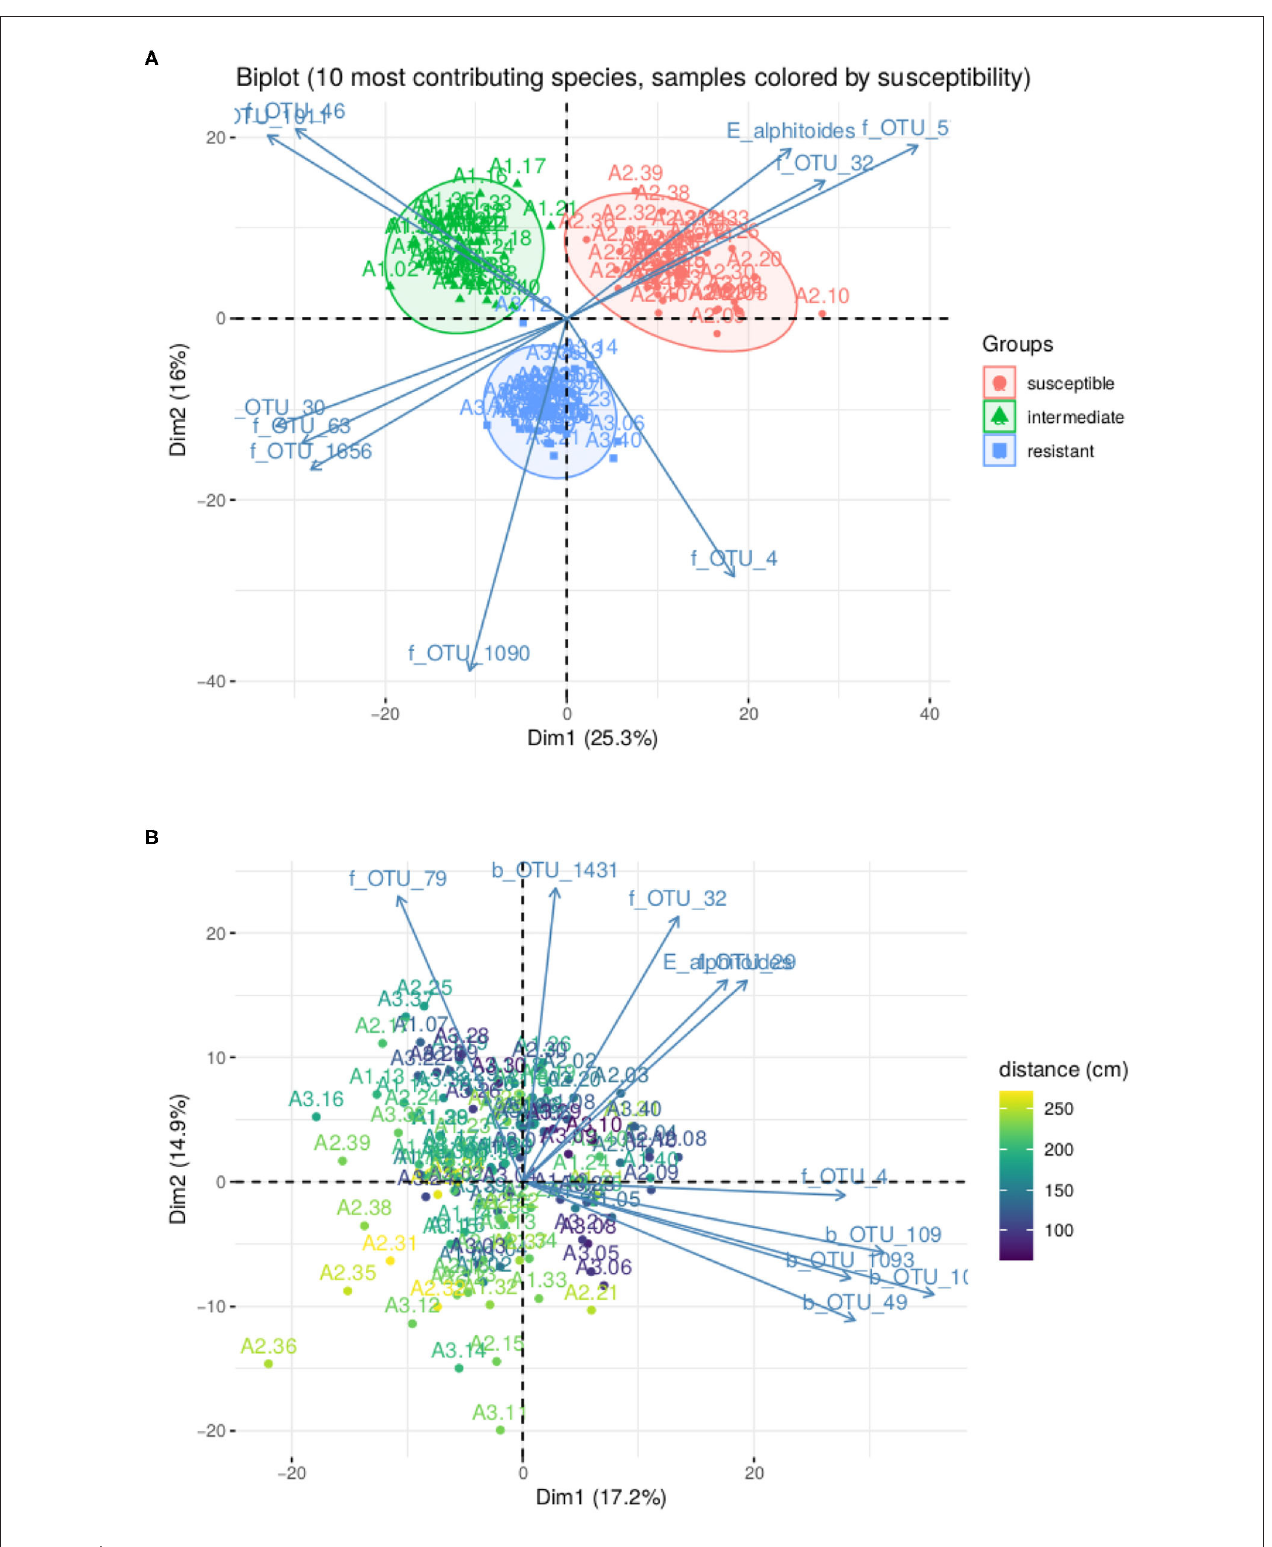
FIGURE 5 | Result of PLN-PCA analysis on oaks powdery mildew data set. (A) Biplot for the first two axes without correction for susceptibility. (B) Biplot for the first two axes after correction for susceptibility. Color gradient corresponds to distance to ground.